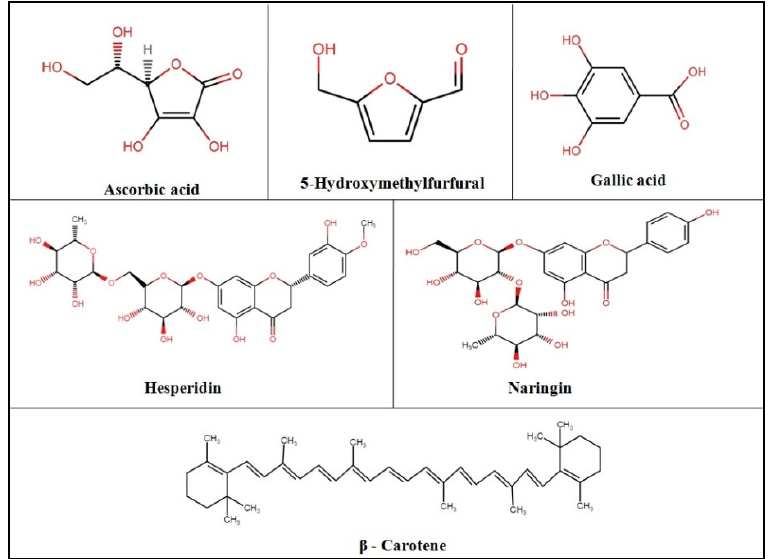
Figure 5. Chemical structure of ascorbic acid, 5-Hydroxymethylfurfural, gallic acid, hesperidin, naringin, and β-Carotene (ChemIDPlus database) [39].